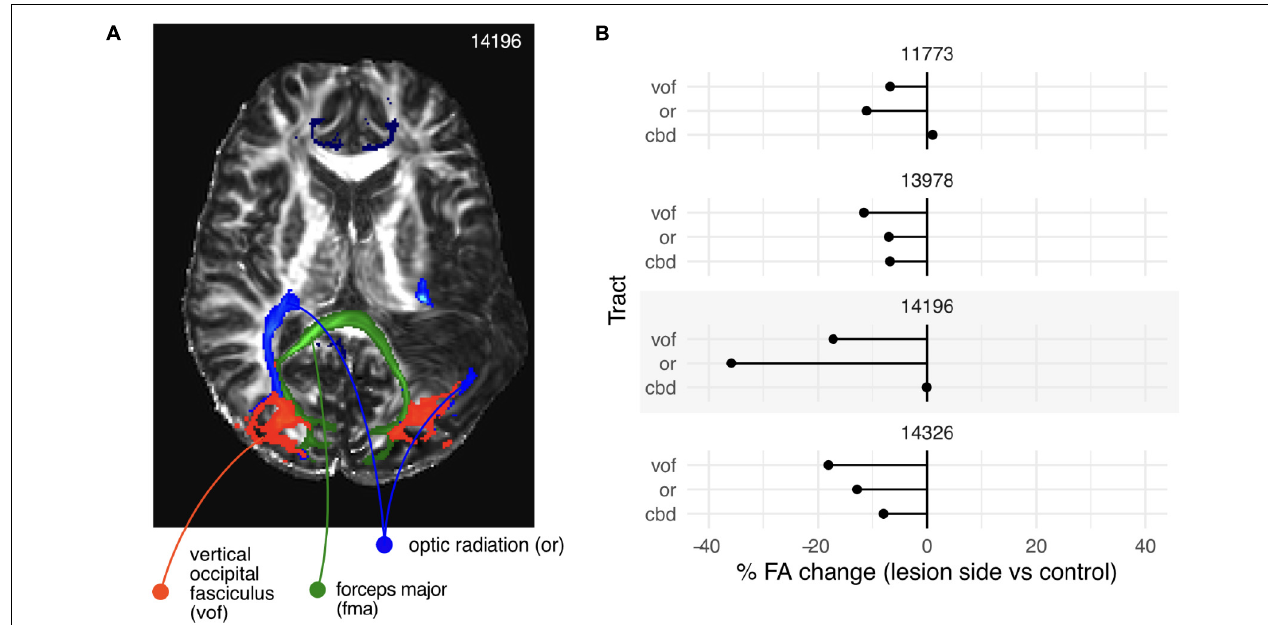
FIGURE 4 | White matter intactness, results from diffusion weighted imaging and analysis. (A) White matter tracts identified from diffusion weighted data by probabilistic tractography ( probtrackx). Blue, optic radiations (left and right); red, vertical occipital fasciculi (left and right); green, forceps major , a large fiber bundle of the corpus callosum connecting visual areas in the left and right hemisphere. Grayscale image, map of fractional anisotropy. (B) Percentage change in fractional anisotropy between the lesioned and non-lesioned hemisphere for vof, or, and cbd. For all participants (sub-panels), there was a clear reduction in the FA values in the lesioned hemisphere up to 40%, although the magnitude and pattern of reduction was markedly different across